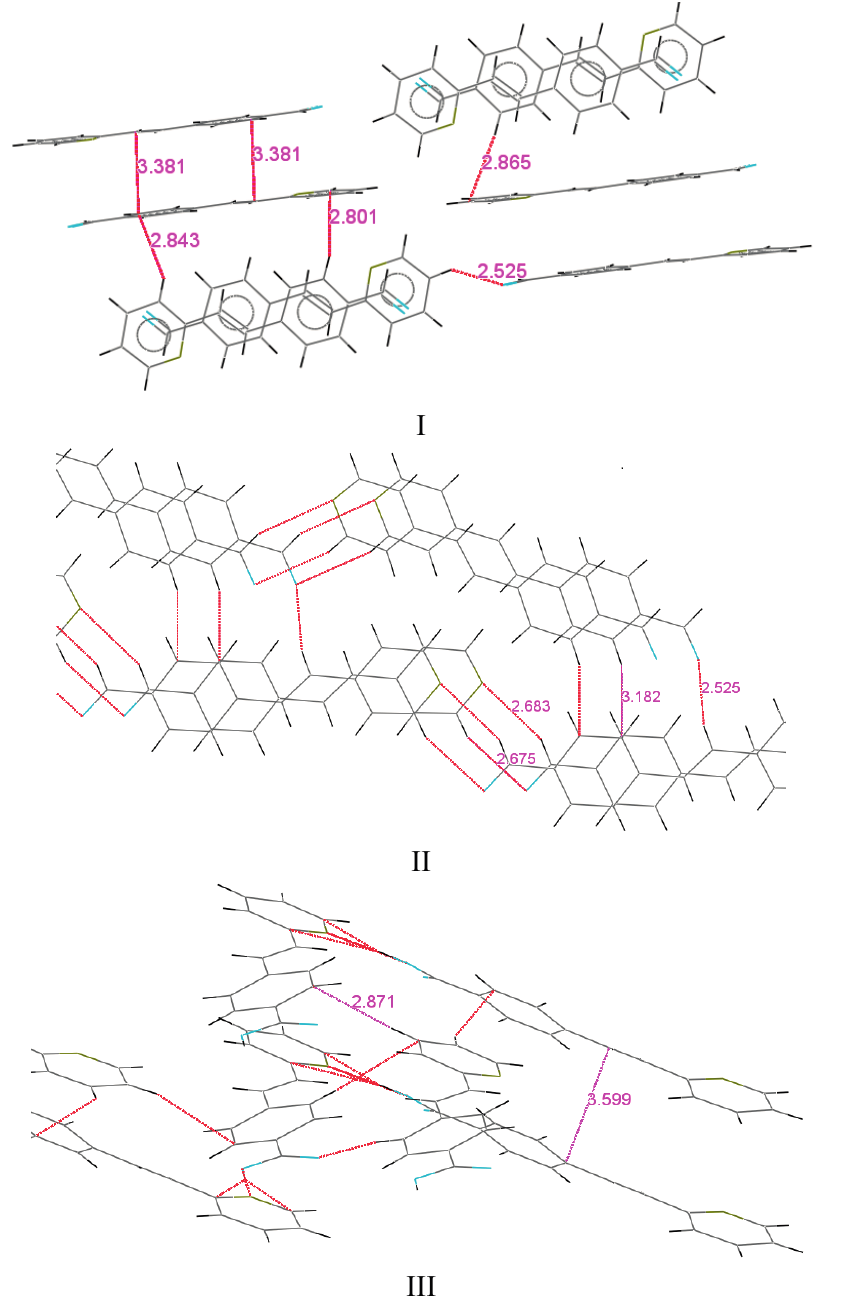
Figure 2. Molecular crystal packing of I , II and III short contacts (dashed red